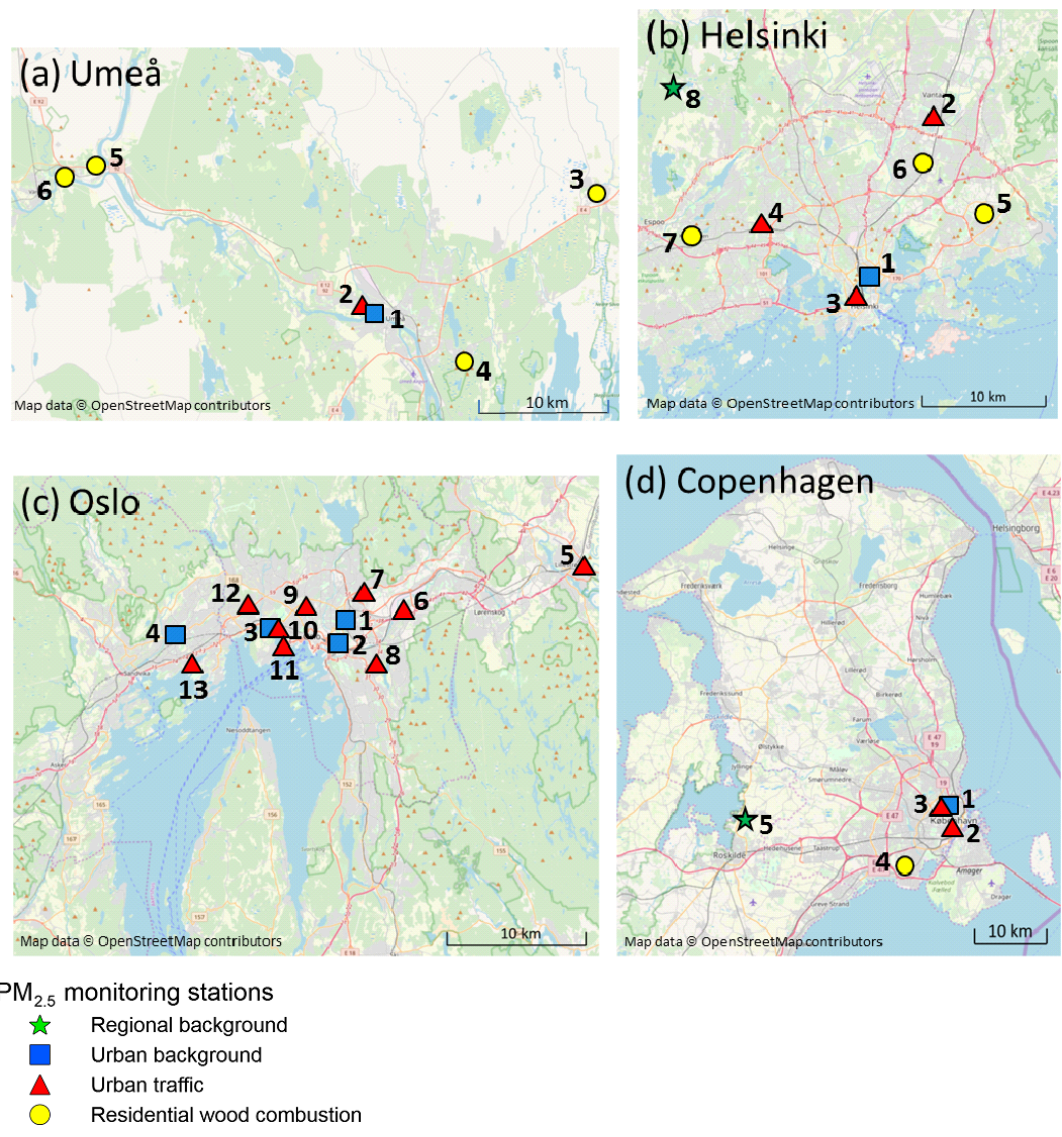
Figure 2. The geographical locations of the cities and the air quality measurement stations for (a) Umeå, (b) Helsinki, (c) Oslo and (d) Copen- hagen. The panels represent the locations of the stations in 2011 for Umeå, 2013 for Helsinki and Oslo, and 2014 for Copenhagen, respec- tively. The most densely populated central areas of the cities are shown with a light mauve colour. Notation for the stations is as follows. (a) Umeå: (1) Biblioteket, (2) Västra Esplanaden, (3) Sävar, (4) Tavleliden, (5) Vännäsby, (6) Vännäs. (b) Helsinki: (1) Kallio, (2) Tikkurila, (3) Mannerheimintie, (4) Leppävaara, (5) Vartiokylä, (6) Tapanila, (7) Kauniainen, (8) Luukki. (c) Oslo: (1) Sofienbergparken, (2) Grøn- land, (3) Skøyen, (4) Bekkestua, (5) Vigernes, (6) Alnabru, (7) Rv4 Aker Sykehus, (8) Manglerud, (9) Kirkeveien, (10) Bygdøy Alle, (11) Hjortnes, (12) Smestad, (13) Eilif Dues vei. (d) Copenhagen: (1) HCØ, (2) HCAB, (3) JGTV, (4) Hvidovre, (5) Risø. ©